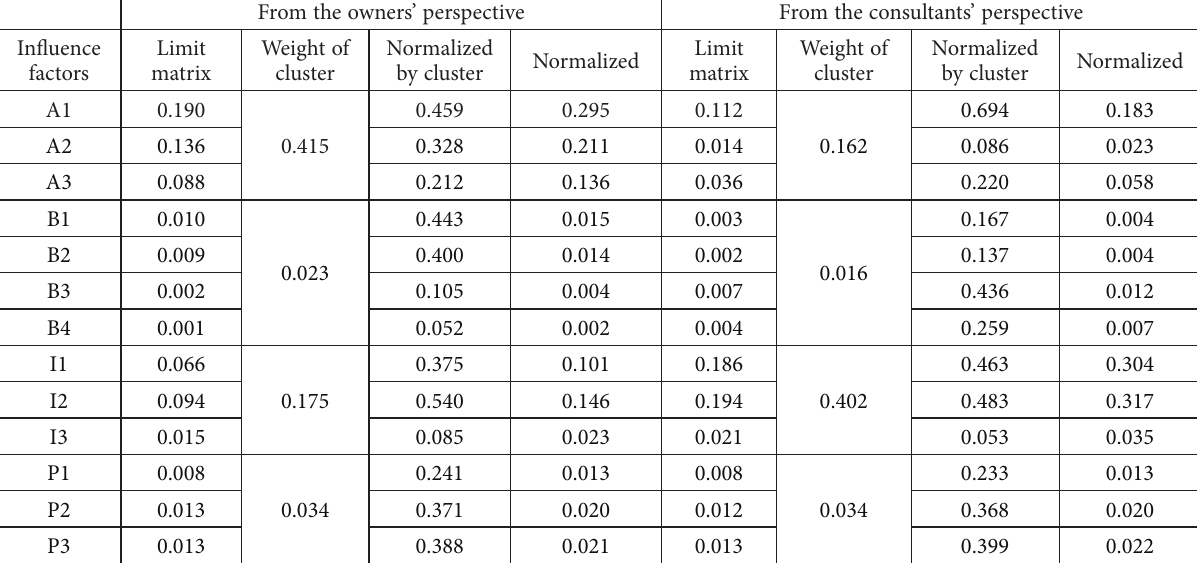
Table 4. Final priorities of the factors that influence initial trust for owners and consultants